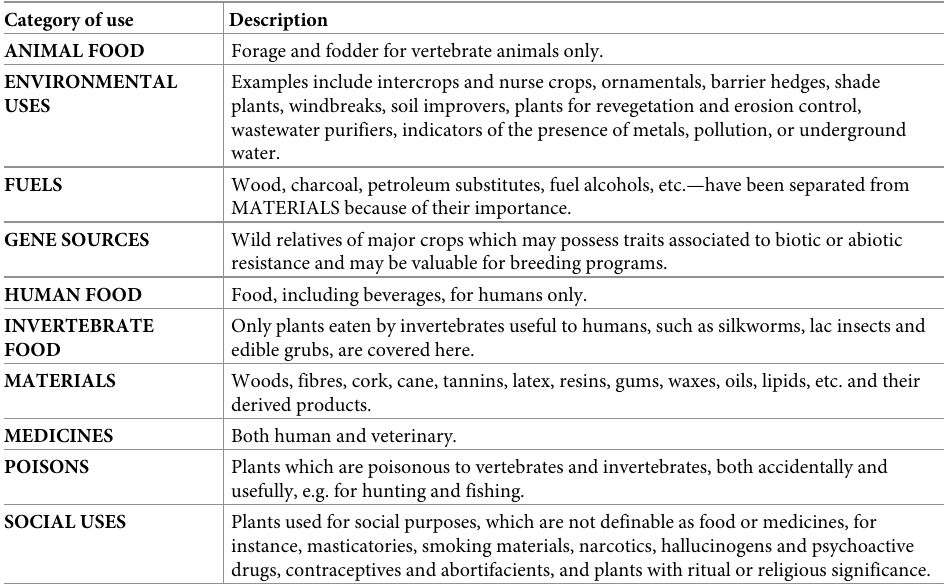
Table 1. Categories of plant uses following Diazgranados et al. (2020).